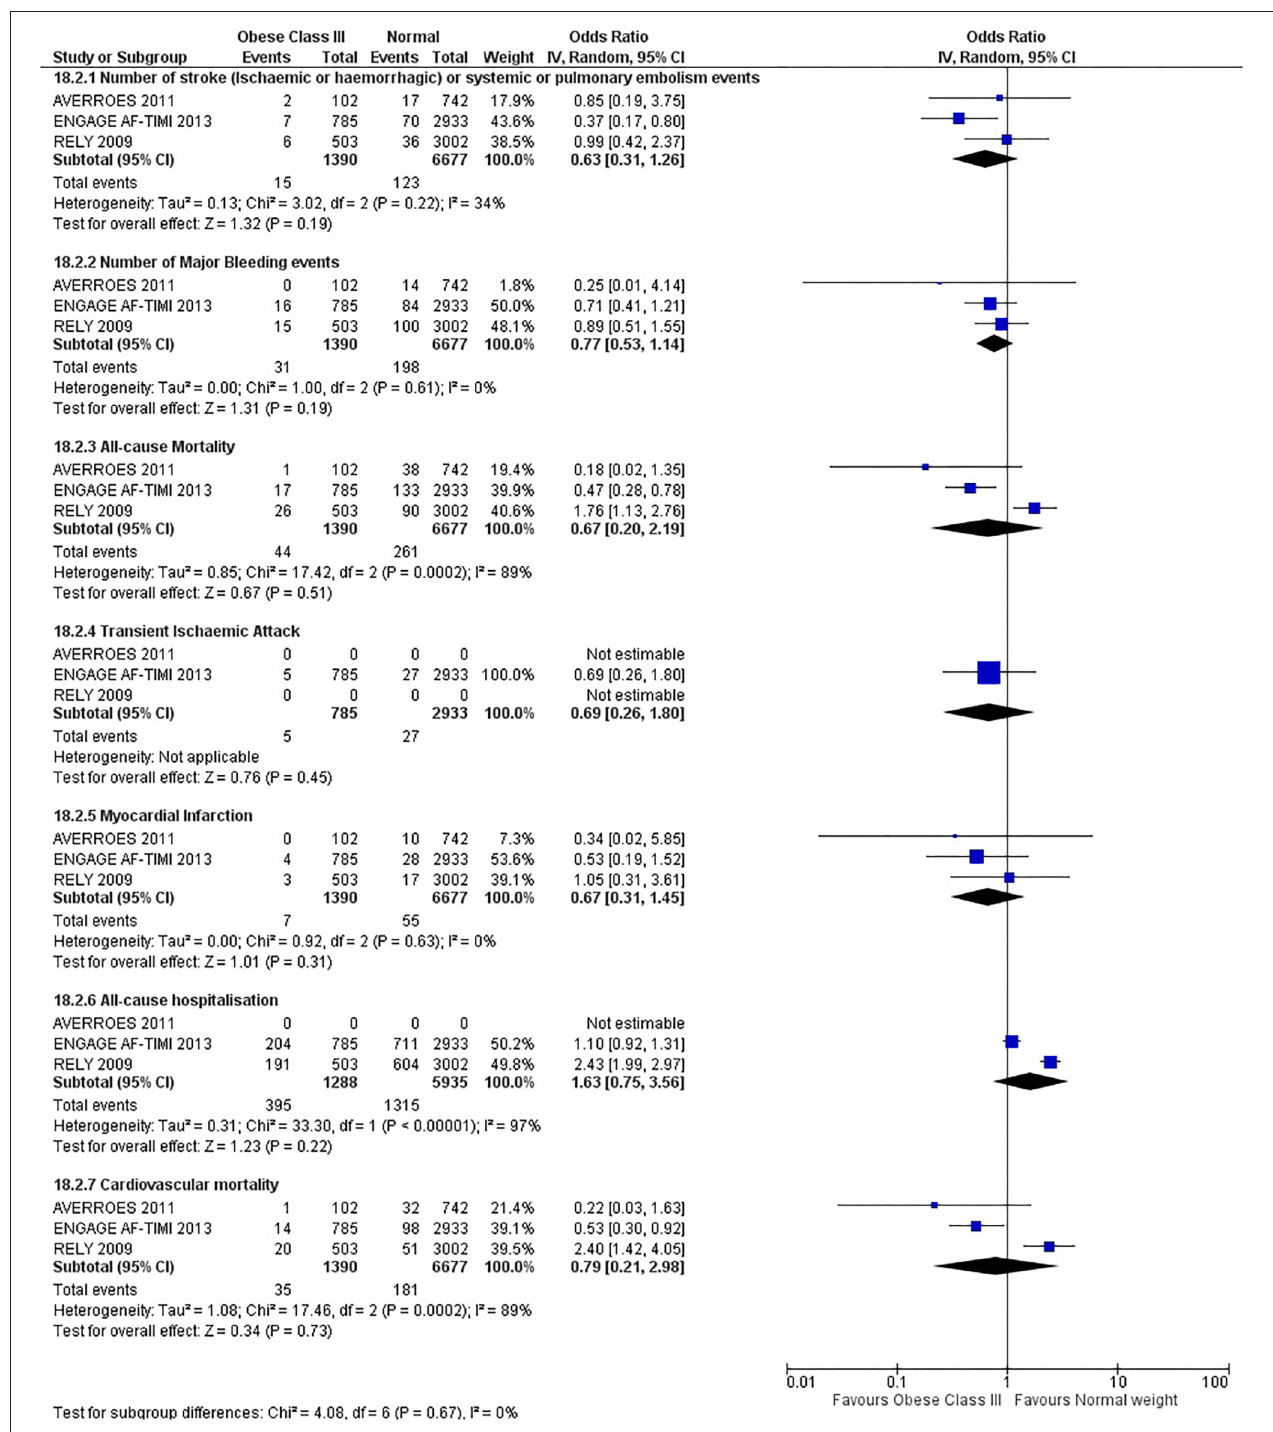
FIGURE 7 | Forest plot of comparison: Normal vs. Obese class III at 12